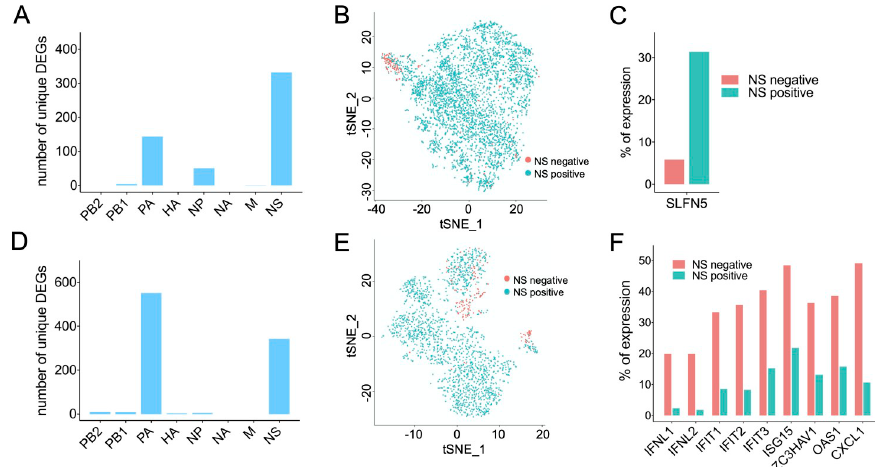
Fig 6. Dissection of the effects of individual viral gene expression on the host transcriptional response to infection. (A) The number of host transcripts for which expression levels significantly differ depending on whether the indicated Cal07 gene segment is present or not, according to both MAST and NBID (host genes that are differentially regulated by the expression status of more than one viral segment are excluded). (B) tSNE plot of all Cal07-infected A549 cells colored based on whether NS segment-derived transcripts are detected (Cyan) or not detected (Salmon). (C) Percentages of NS negative and NS positive Cal07-infected A549 cells that have detectable levels of SLFN5. (D) Same figure as (A) for Perth09. (E) Same figure as (B) for Perth09. (F) Percentages of NS negative and NS positive Perth09-infected A549 cells that have detectable levels of the indicated host transcripts.